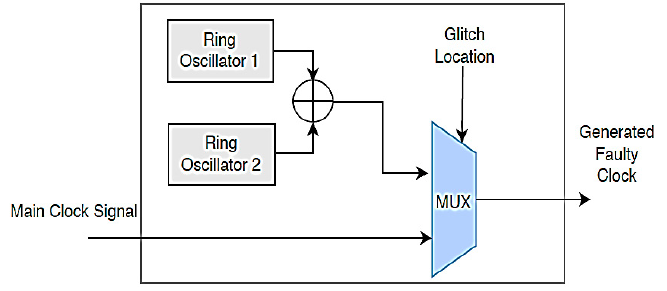
Figure 14. Glitch insertion circuitry using two ring oscillators [38].